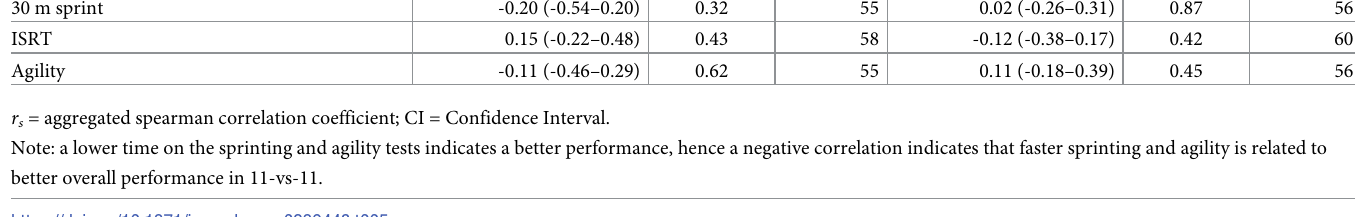
Table 5 presents Spearman’s correlations between the players’ performance on the physiological and motor tests and the overall offensive performance (left), and the overall defensive perfor- mance (right) in the 11-vs-11 games (see S6 Table for correlations per team). The aggregated coefficients were negative small or trivial for 10 m sprint and 11-vs-11 performance ( r